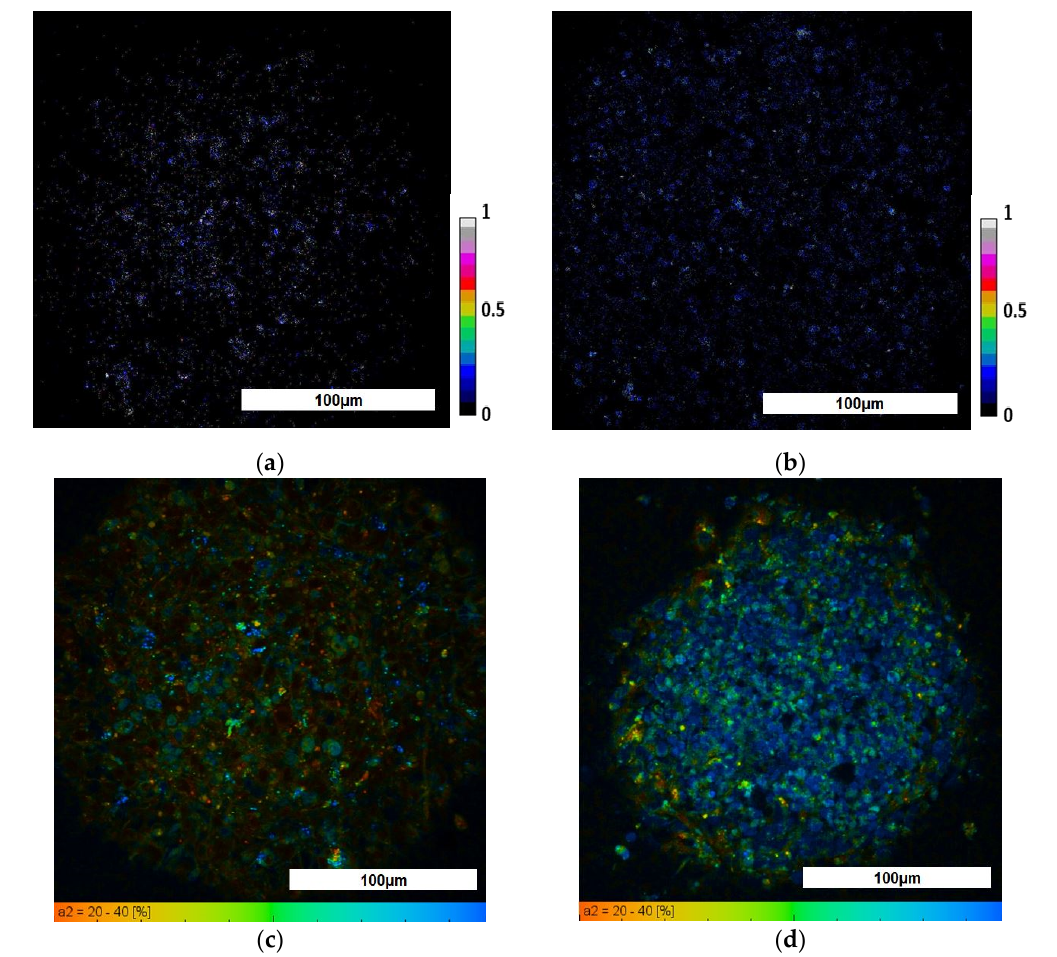
Figure 7. Multiphoton fluorescence microscopy and FLIM of NAD(P)H in TS21 and NK spheroids: ( a ) Optical redox image (fluorescence intensity of FAD/NAD(P)H) of TS21 spheroid; ( b ) Optical redox image (fluorescence intensity